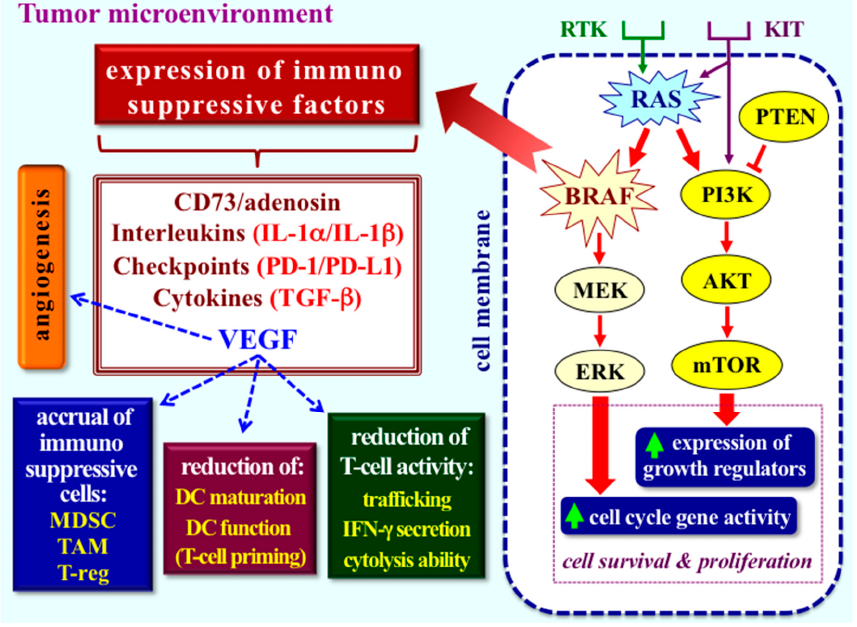
Figure 4. Intracellular molecular alterations and their effects on tumour microenvironment immune activity. Activated MAPK pathway in melanoma cells triggering immune escape mechanisms. Arrow, activating regulation, interrupted line, negative regulation. RTK, receptor tyrosine kinase. IFN, interferon. IL, interleukin. MDSC, myeloid-derived suppressor cell. TAM, tumour-associated macrophage. T-reg, regulatory T cell. DC, dendritic cell.